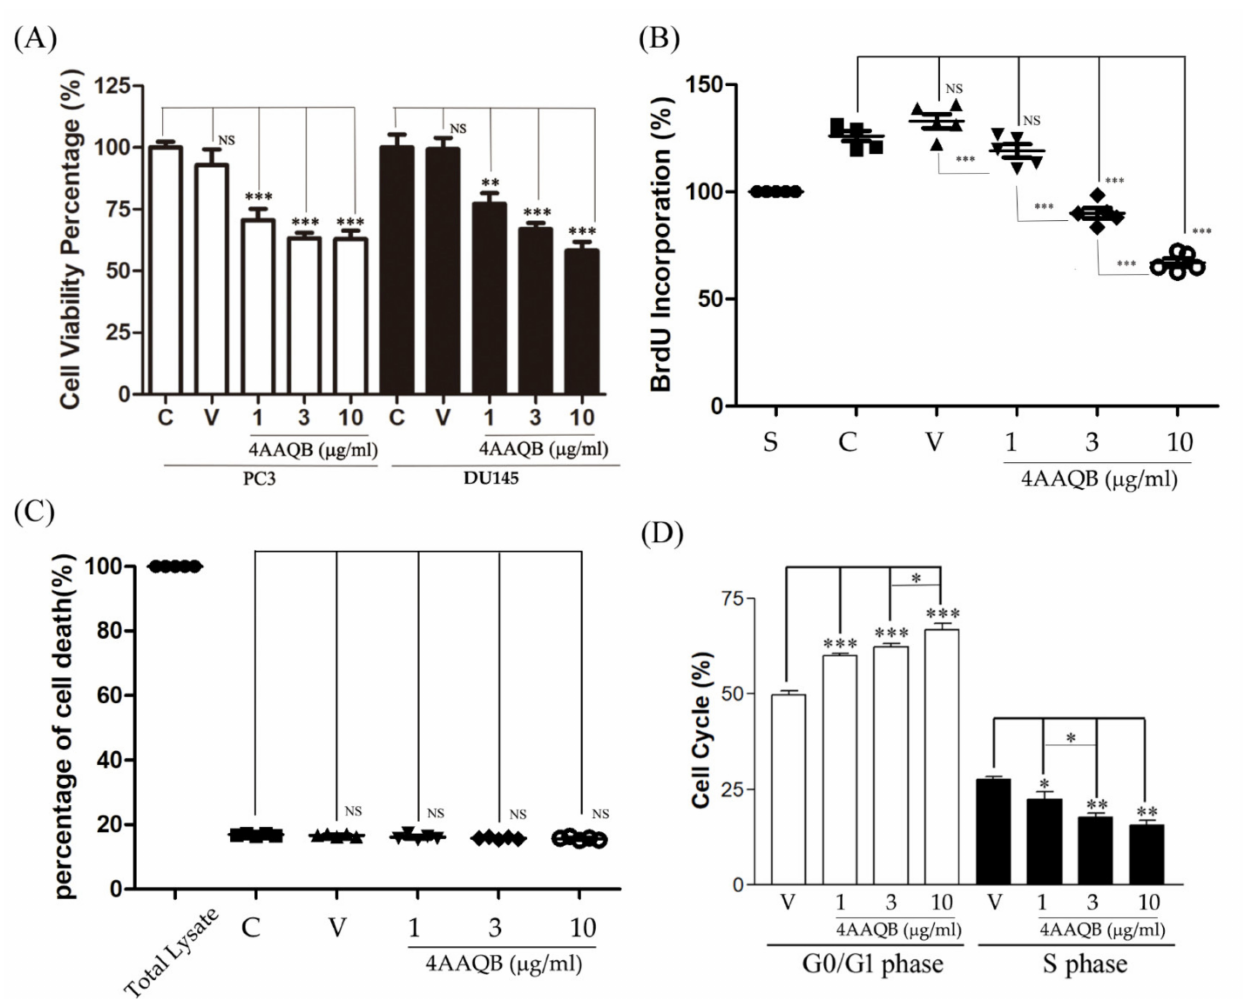
Figure 1. The effects of 4AAQB on prostate cancer cell viability, cytotoxicity, and cell cycle: ( A ) PC3 cell viability was detected via an MTT assay and DU145 cell viability was detected via an SRB assay; ( B ) the antiproliferation effect of 4AAQB in PC3 cell was detected via a BrdU assay. Data are represented as means ± SEM ( n = 5); ( C ) LDH release was detected according to the manufacturer’s protocol. Data are represented as means ± SEM ( n = 6); ( D ) PC3 cells were treated with a vehicle (V) or 4AAQB and analyzed by flow cytometry. The cell cycle distribution is shown as percentages in the cell cycle phases. Data are represented as means ± SEM ( n = 6). * p < 0.05, ** p < 0.01, and *** p < 0.001 compared to the control (C) or vehicle (V) groups. S indicates the starvation group. NS: